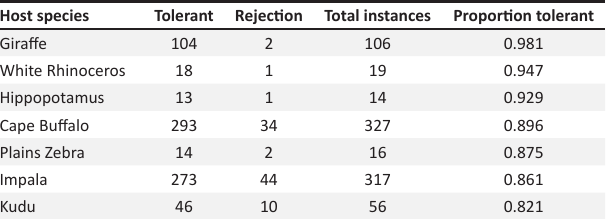
FIGURE 4: Body-location preferences on the preferred hosts of Red-billed Oxpeckers in the Skukuza and Shingwedzi areas.